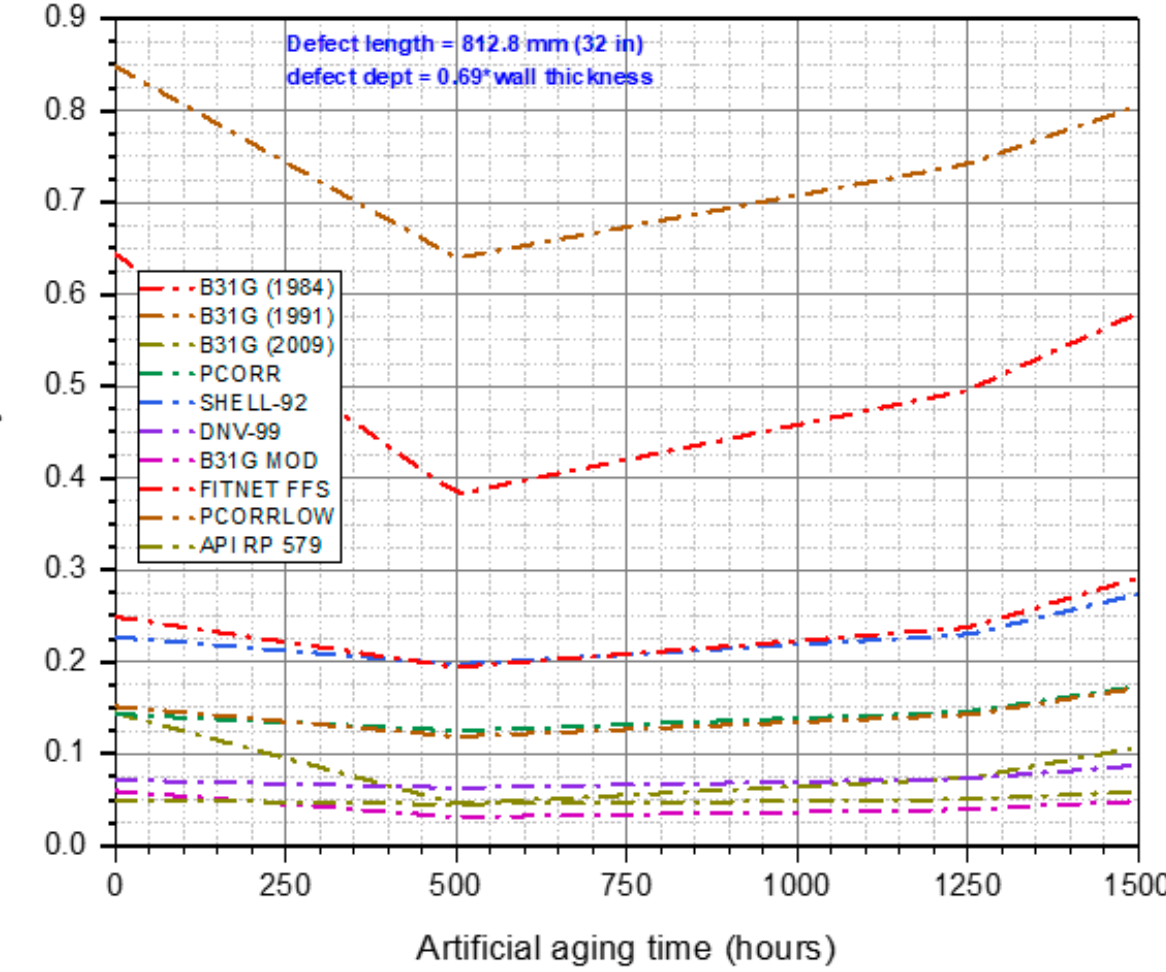
Figure 12. Pipeline failure pressure evolution for different artificial aging times for pipeline steel.